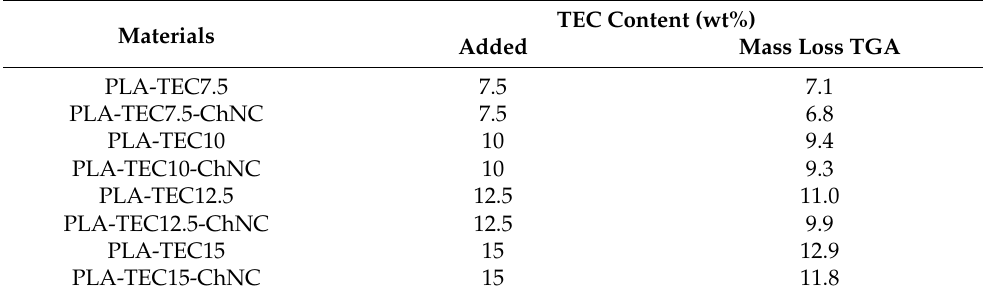
Table 1. Mass loss of TEC from the nanocomposites at the isothermal temperature.